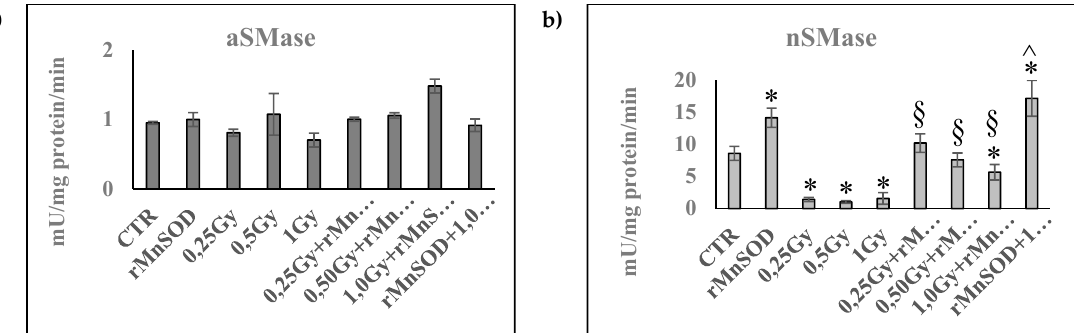
Figure 4 . Effect of radiation and rMnSOD on aSMase and nSMase activity in the liver. aSMase and nSMase activity evaluated using an Amplex Red Sphingomyelinase assay kit, as reported in the “Materials and Methods” section. Livers from the mice treated with increasing doses of radiation with or without rMnSOS. ( a ) aSMase; ( b ) nSMase. Data are expressed as mU/mg protein/min and represent the mean+SD of three liver samples, each carried out in triplicate. Significance: a) * p < 0.05 versus the control sample (CTR); b) § p < 0.05 rMnSOD treated and irradiated samples versus the irradiated samples; c) ^ p < 0.05 pretreated and 1.0 Gy irradiated sample versus the 1.0 Gy irradiated and rMnSOD treated sample. CTR, control mice; rMnSOD, mice treated with human recombinant manganese superoxide dismutase; 0.25 Gy, 0.5 Gy, and 1.0 Gy, mice exposed to increasing radiation doses; 0.25 Gy + rMnSOD, 0.5 Gy + rMnSOD, and 1.0 Gy + rMnSOD, mice exposed to increasing radiation doses and treated with rMnSOD (protective role of rMnSOD); rMnSOD + 1.0 Gy, mice pretreated with rMnSOD and exposed to 1.0 Gy radiation (preventive role of